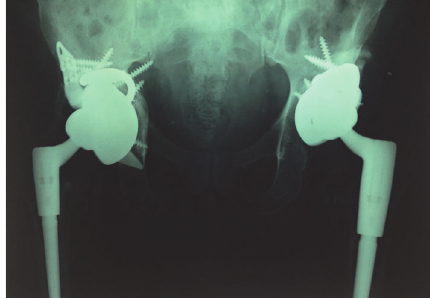
Figure 16: Postoperative anteroposterior pelvic plain film radio- graphs showing second-stage THR revisions in situ.